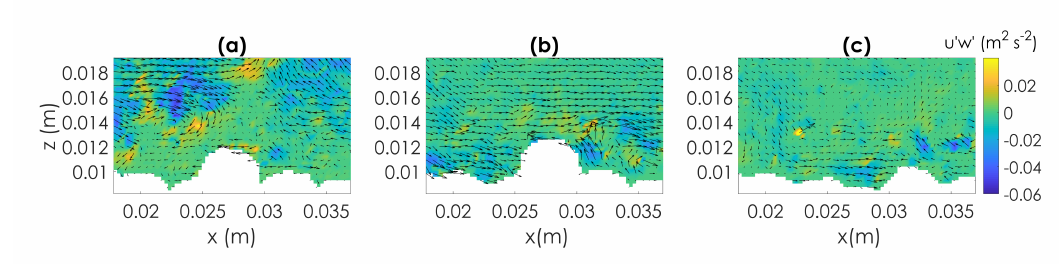
Figure 12. Instantaneous Reynolds shear stress maps with vectors superimposed representing velocity fluctuations obtained for Type A; (particle 12, Test T1) for the sequence of three PIV images reported in Figure 11. The sediment bed is masked in white. (For clarity only 1 out of 2 vectors are depicted.) ( a ) At time t = t 0 a sweep event ( u (cid:48) > 0 and w (cid:48) < 0), is clearly identifiable in blue on the middle/top and left side of the image, is approaching. The remaining of that is observed in the next instant ( b ) on the upstream side of the particle about to be dislodged. In the next instant ( c ) the particle has already been dislodged and parcels of fluid characterized by intense Reynolds stresses (in blue) at the location previously occupied by the particle.